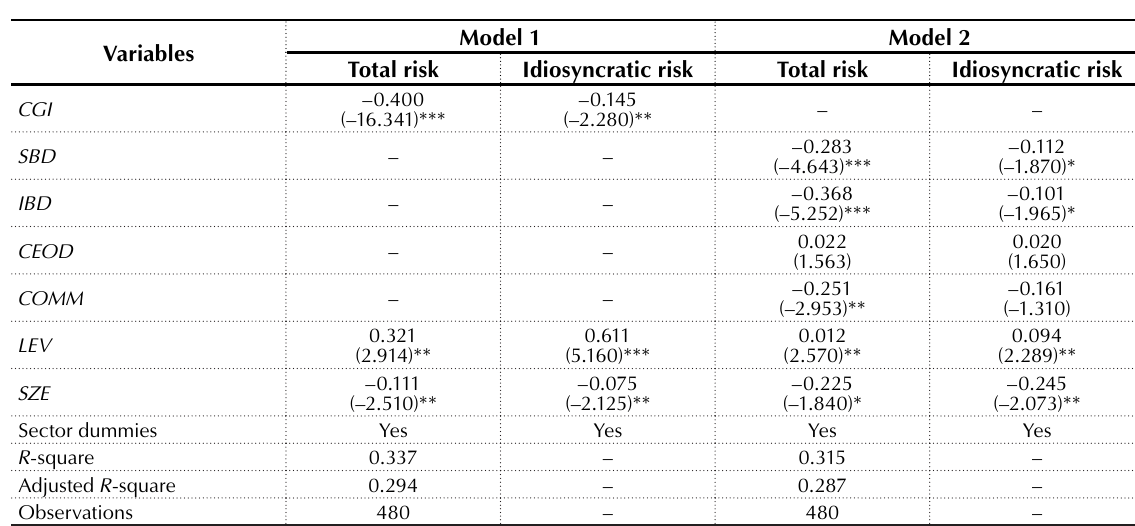
Table 7. Regressions models on corporate risk